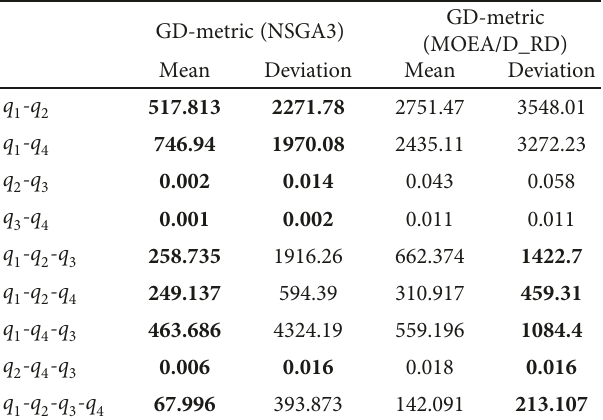
Table 9: Comparison of GD-metric of MOEA/D_RD and NSGA3. GD-metric (NSGA3)